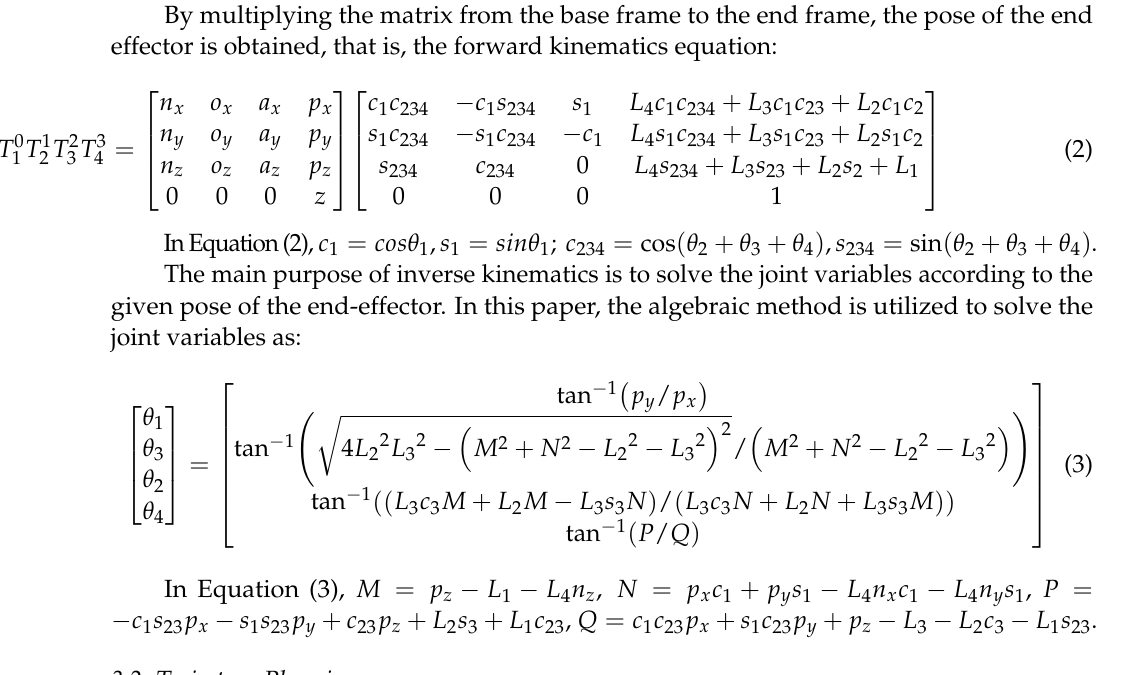
Figure 4. Setting of the manipulator coordinate system .